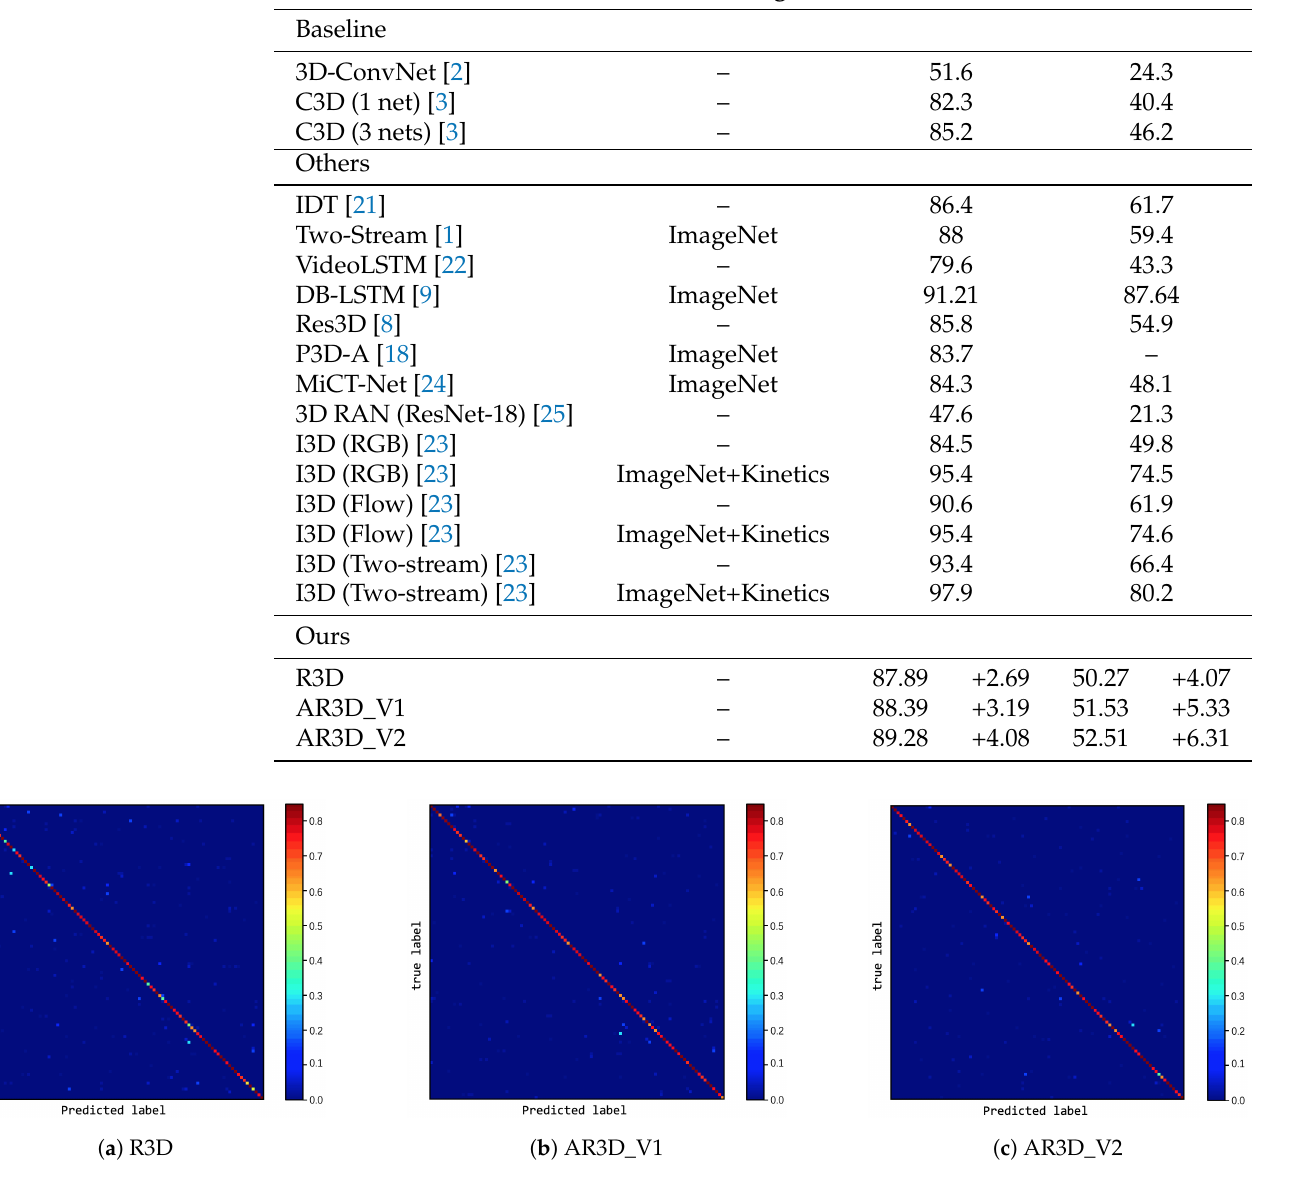
Figure 10. Confusion matrix of three proposed models on UCF101.